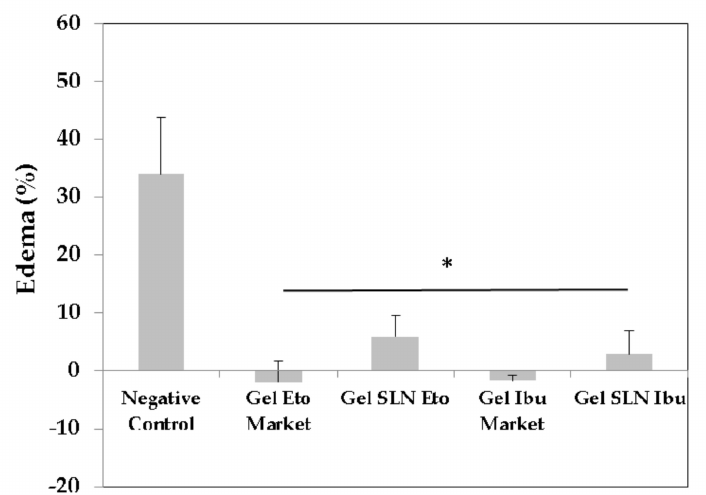
Figure 11. Paw edema (%), 5 h after carrageenan injection in different test groups: induced non treated animals (Negative control), etofenamate reference gel (Gel Eto Market-Reumon ® Gel 5%), etofenamate-SLN hydrogel (Gel SLN Eto), ibuprofen reference gel (Gel Ibu Market-Ozonol ® 5%) and ibuprofen-SLN hydrogel (Gel SLN Ibu). Data represent the mean ± S.E.M.; n = 5. * p < 0.01 vs. negative